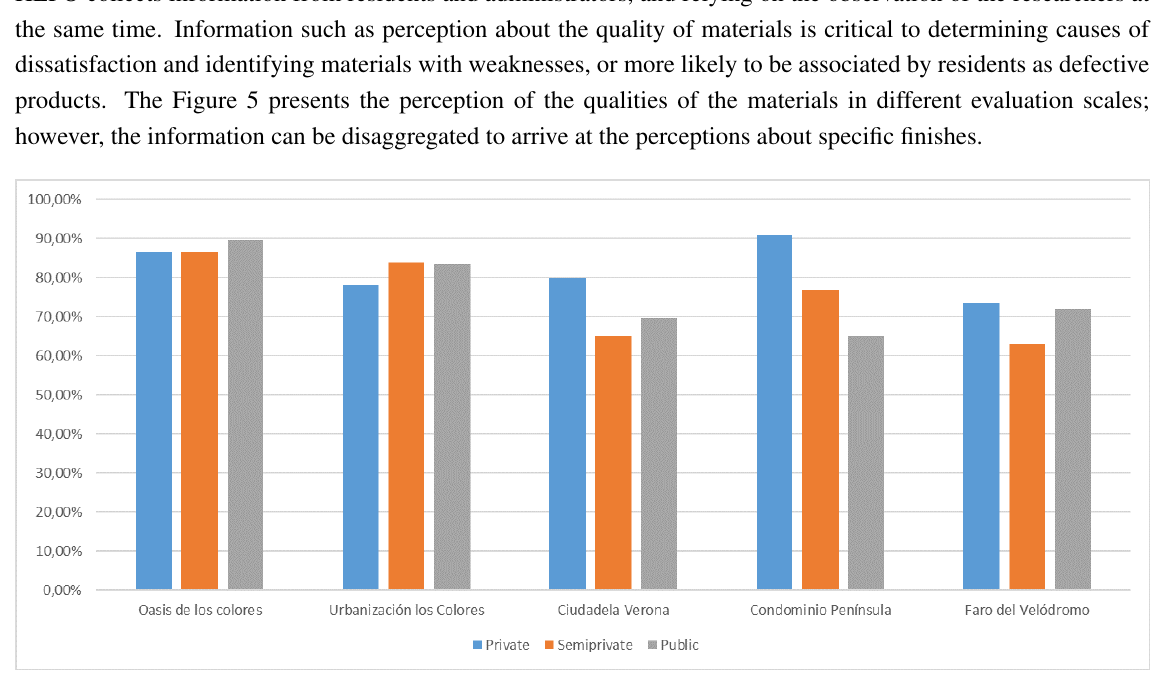
Figure 5. Perception about the aesthetic and